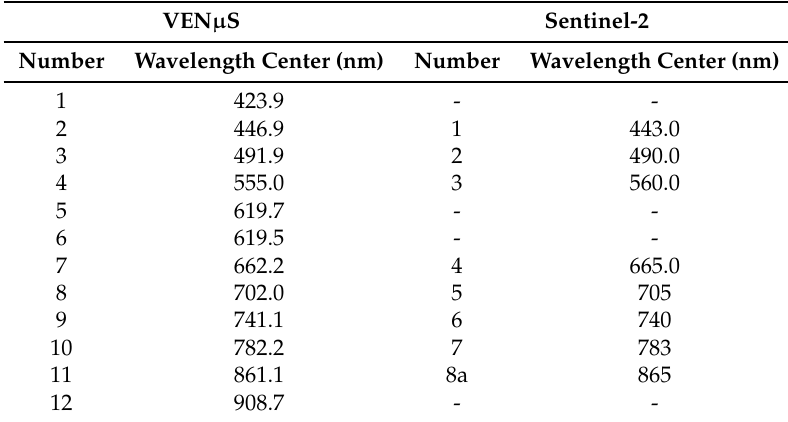
Table 1. Summary of VEN µ S and Sentinel-2 spectral bands.